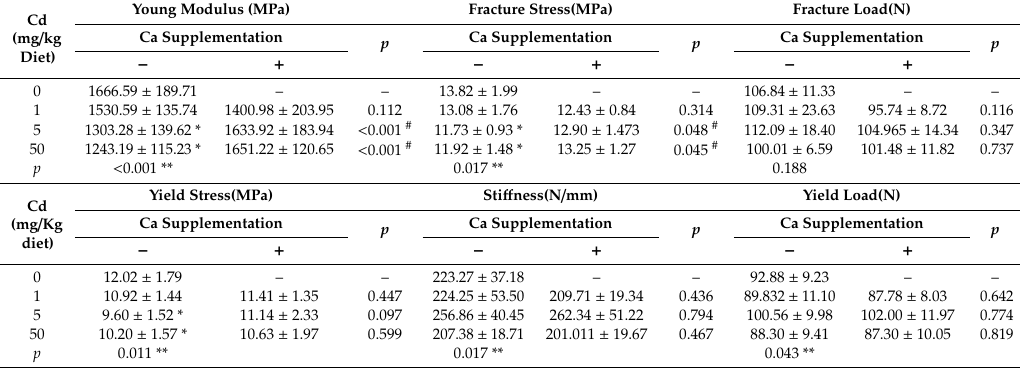
Table 10. Three-point flexural properties of femurs in the study of moderate Ca supplementation exposure to di ff erent diet Cd (Exp 2).